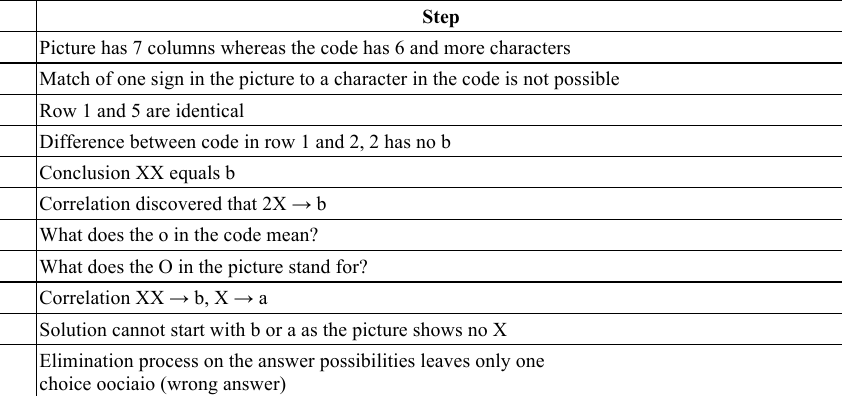
Table 5. Steps of a test person’s think aloud process that lead to a false result.